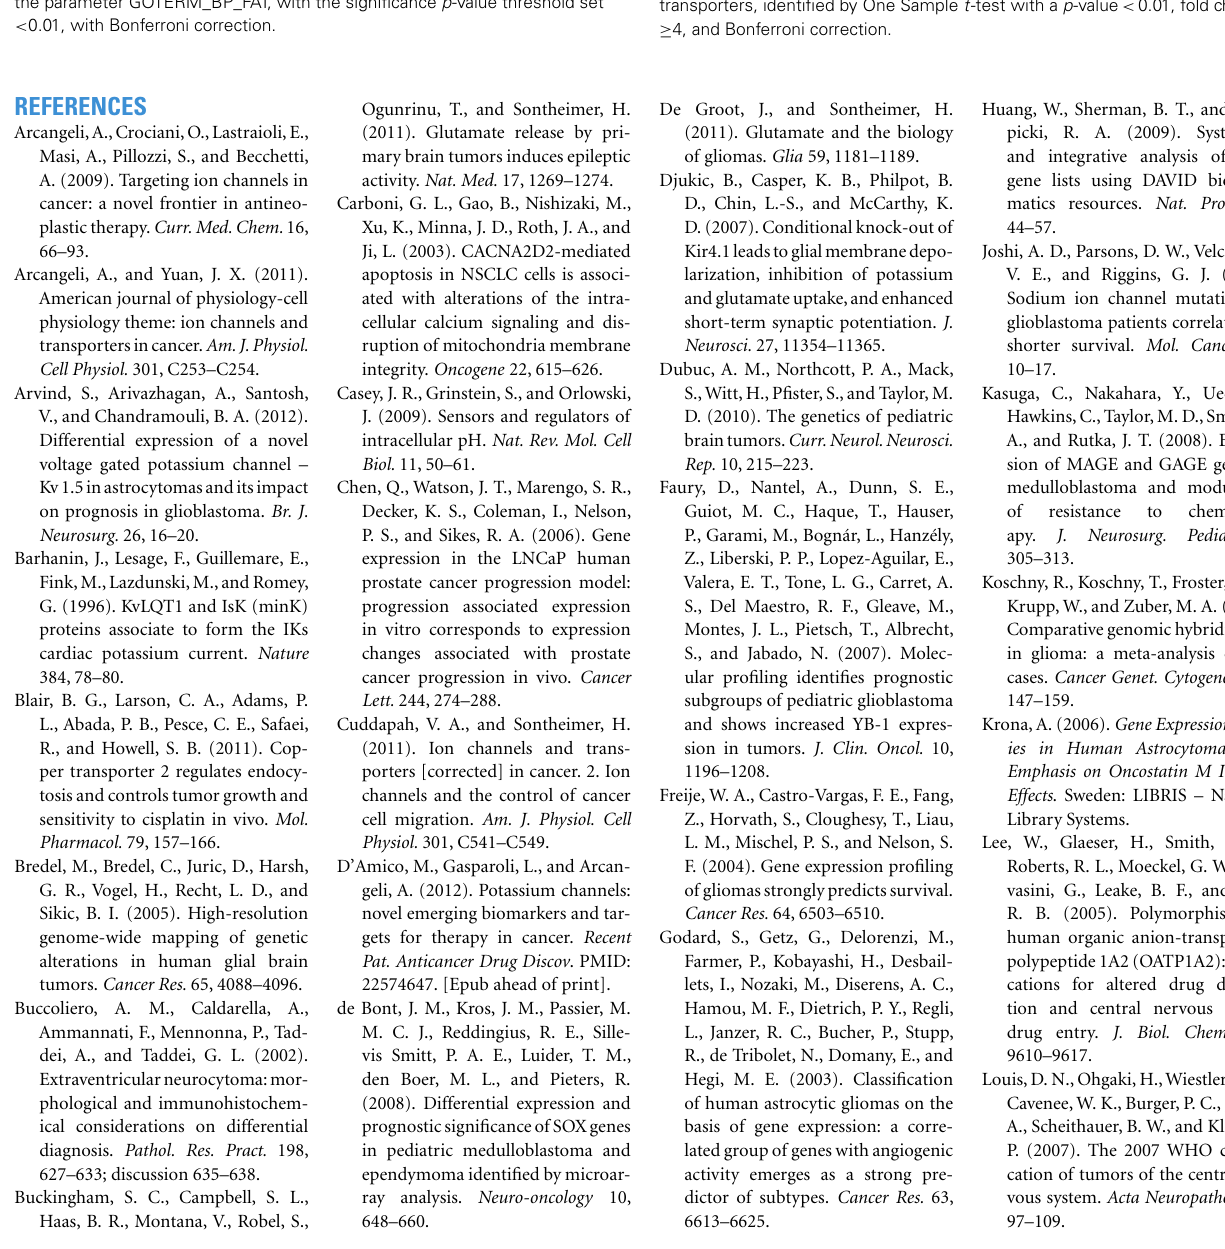
Table S4 | Functional annotation analysis from differentially underexpressed genes. FAA performed using NIH-DAVID software (version 6.7, http://david.abcc.ncifcrf.gov/) on the differentially underexpressed genes reported inTable S1 in Supplementary Material.We used the parameter Table S5 | Differentially expressed genes associated to ion channels and transporters. Sixty-seven DE genes, associated to ion channels